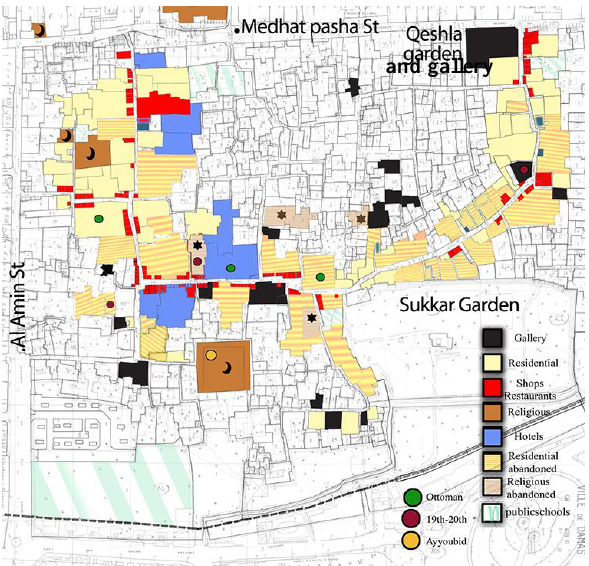
Figure 7. Function survey on the main axe at al-Amin district, R.Aboukhater and Ifpo team, 2010.